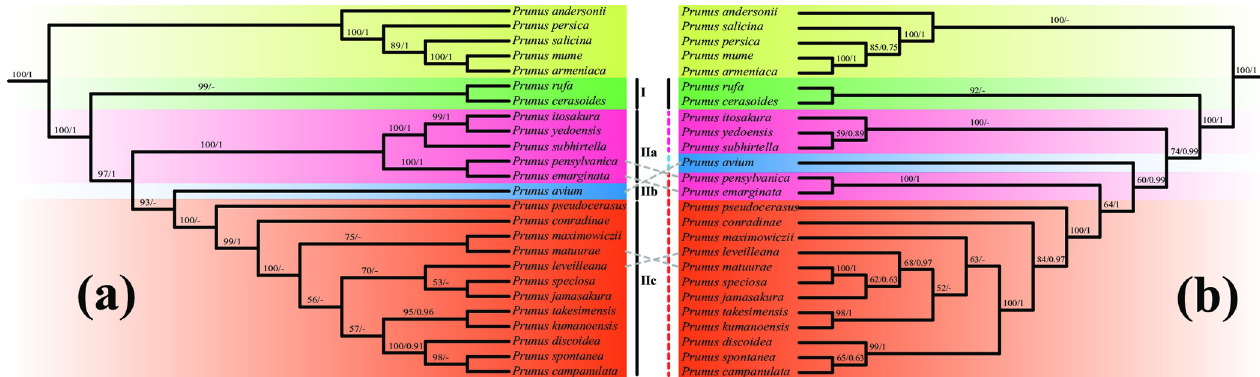
Fig 5. Combined ML and BI phylogenetic trees of 20 subg. Cerasus species based on either (a) complete plastome data or (b) coding region (CDS) data. The support value is displayed above the branch in the order of Maximum Likelihood bootstrap support and Bayesian Inference posterior probability. “-” indicates the branch collapse in the Bayesian tree. Clades, subclades or lineages are indicated by gradual colors of boxes covered on taxa names, taxa with changing molecular placement are connected by dotted lines.